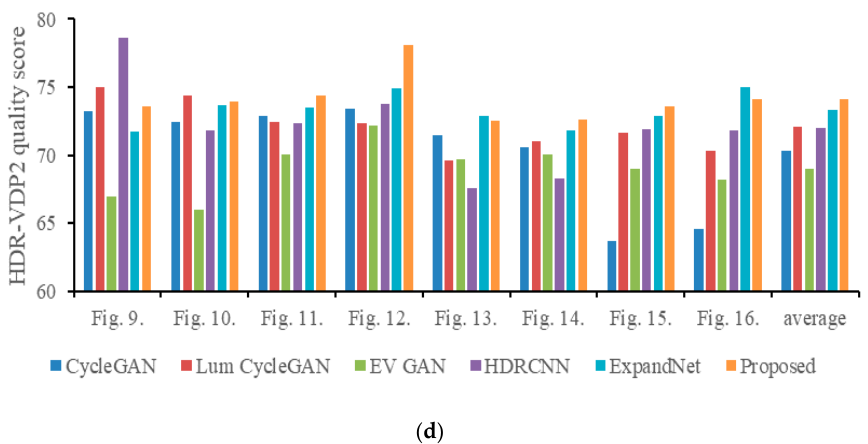
Figure 17. Comparison of metrics: ( a ) perception-based image quality evaluator, ( b ) multiscale structural similarity, ( c ) HDR-VDP2 quality, and ( d ) HDR-VDP2 visibility.